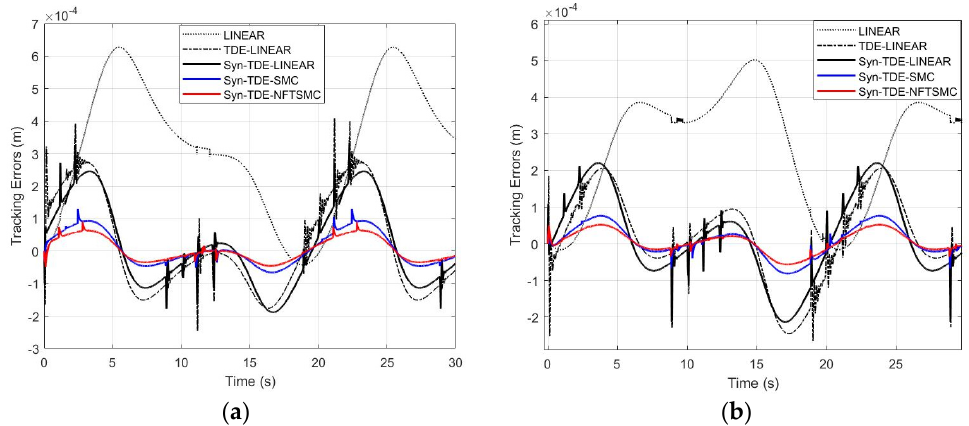
Figure 6. Time trajectories of tracking errors of the control schemes, of joint 1 ( a ) and joint 2 ( b ). Table 3. The absolute average tracking errors (AATE) of the control schemes, computed by MATLAB.